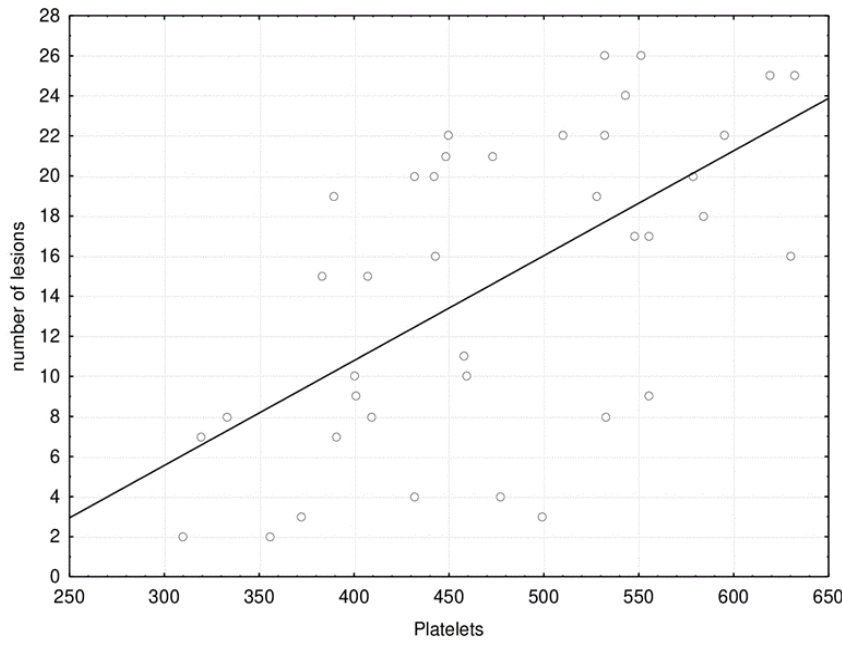
Figure 5. Scatter plot of the correlation between the number of brain lesions with platelet count. The number of brain lesions significantly correlated with the platelet count: Spearman correlation coefficient rho = 0.599 ( p < 0.001). of VAS.